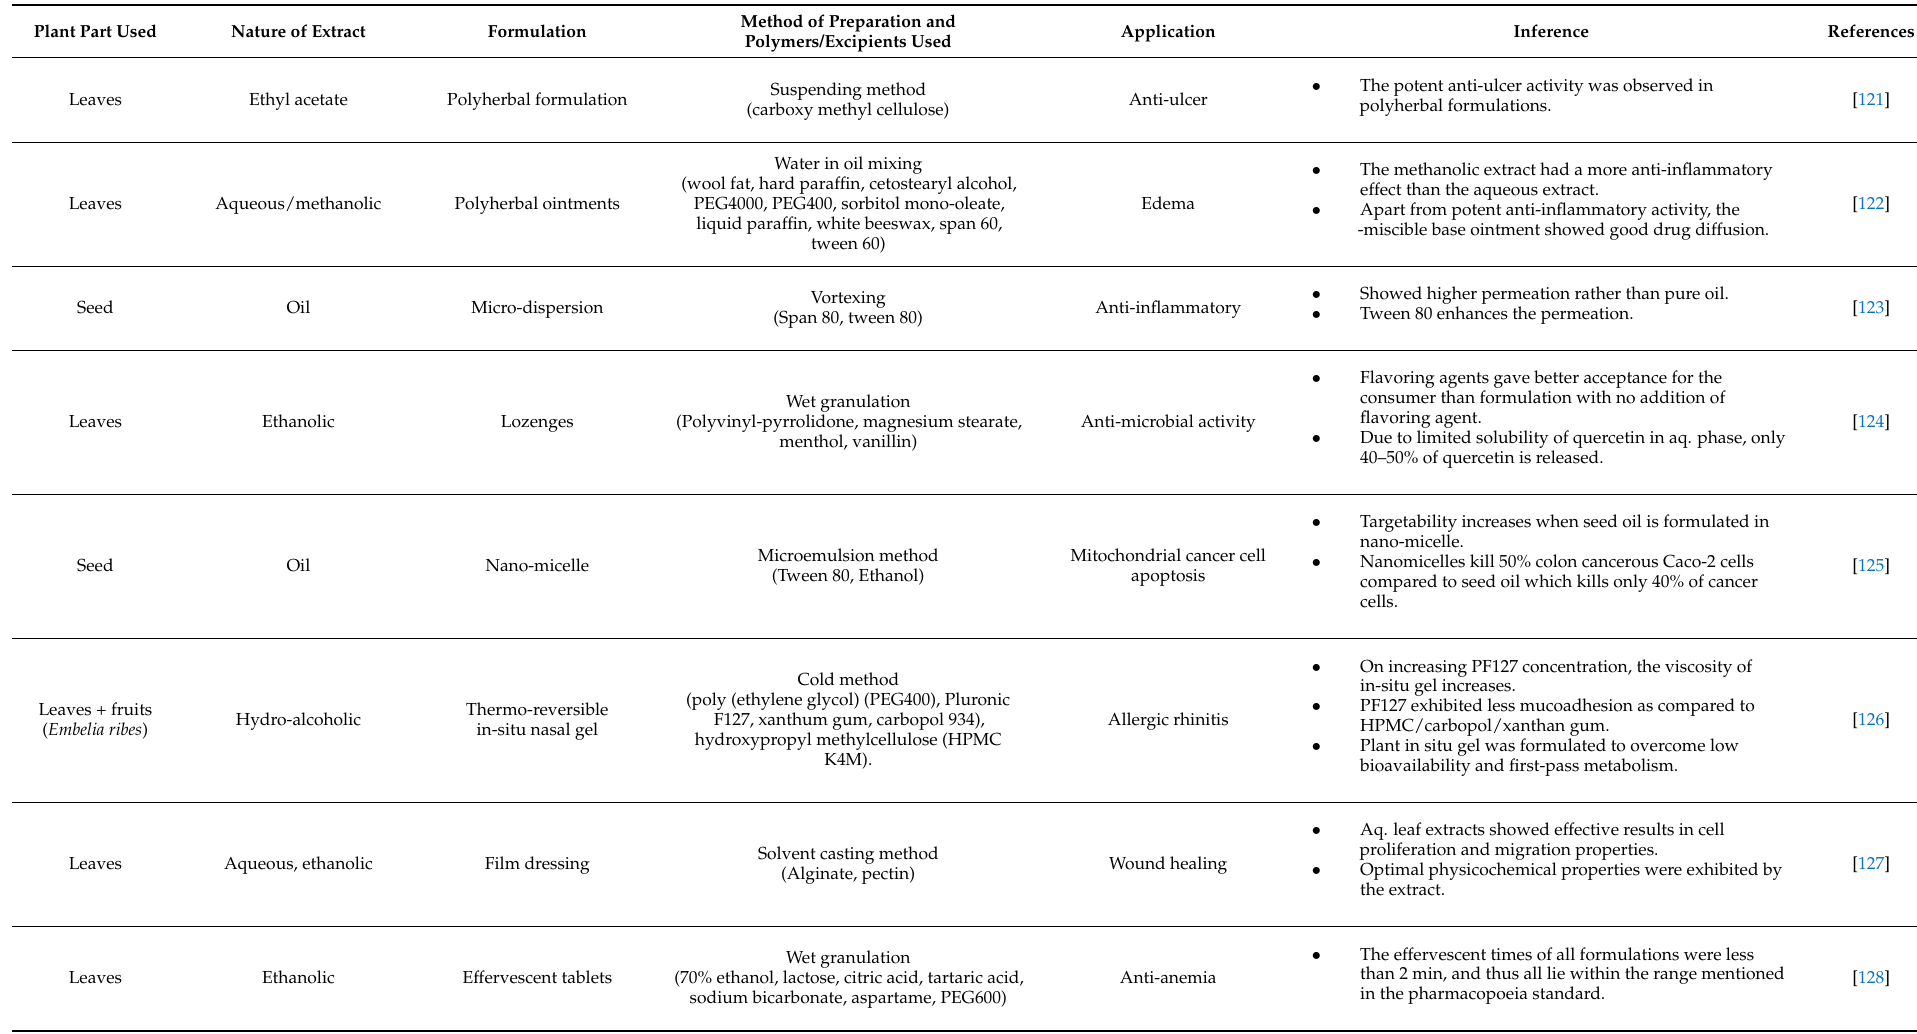
Table 3. Phytopharmaceutical formulations prepared using M. oleifera